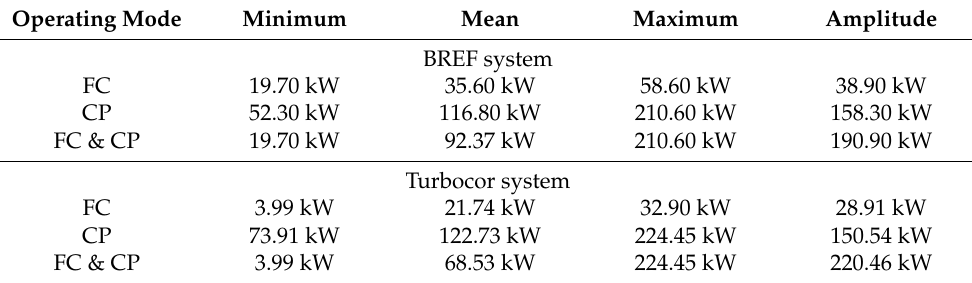
Table 3. Power consumption parameters of cooling systems by operating modes.